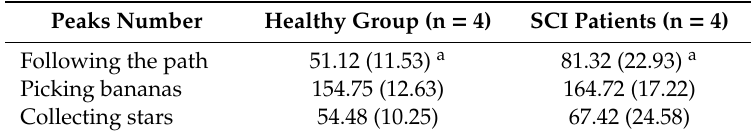
Table 4. Peaks number in each serious game for both experimental groups (a, statistical di ff erences p < 0.05).